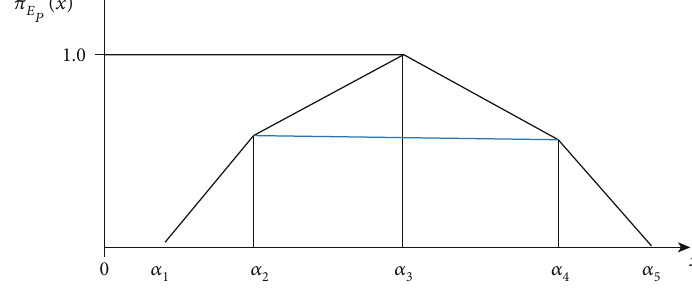
Figure 1: Layout of remaining